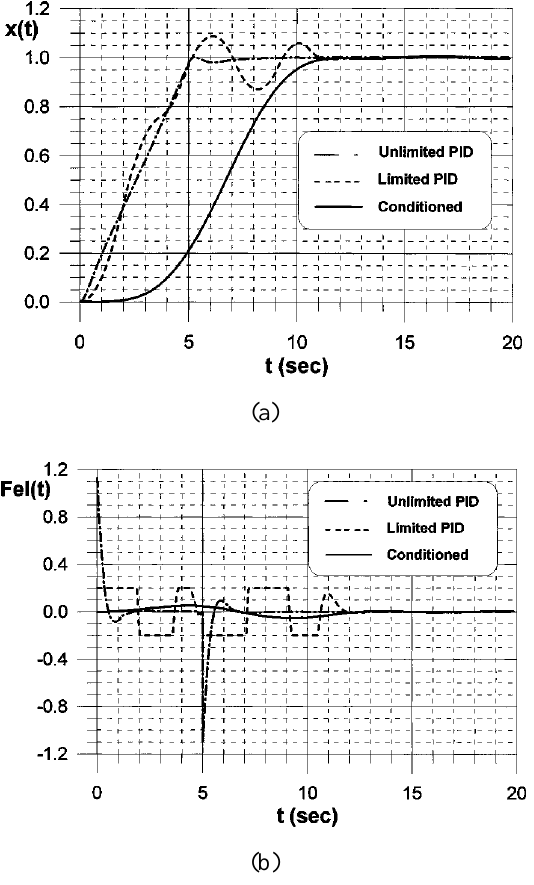
Fig. 13. Residual error function for variations of the damping ratio (cid:16)